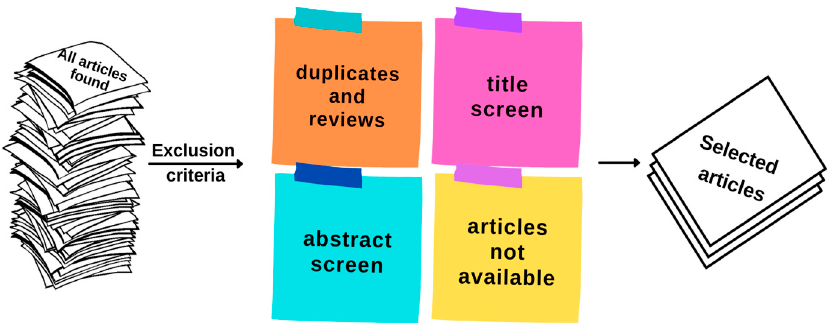
Figure 4. Exclusion criteria to define the studies that were used.